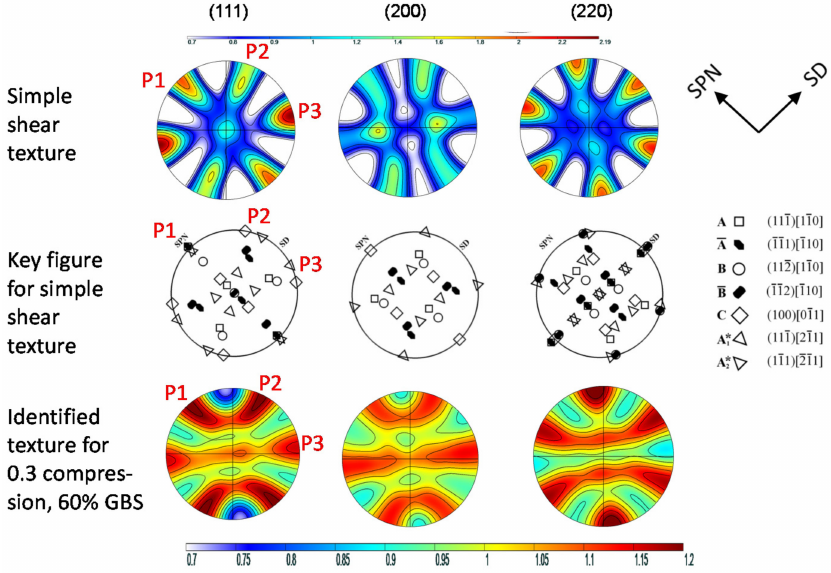
Figure 2. Pole figures simulated for simple shear and 60% grain boundary sliding (GBS) with C = 0.3. Maxima at the periphery evaluated are marked with P1, P2, and P3. The main texture components of simple shear deformed fcc metals (denoted by {hkl} parallel to the shear plane and <uvw> parallel to the shear direction) are given in the key